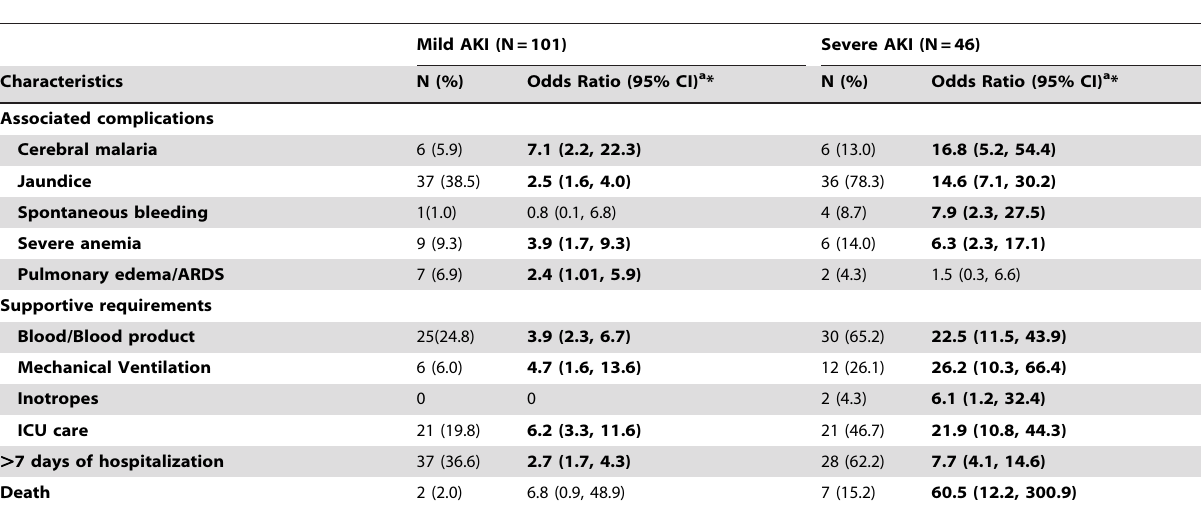
Table 9. Associations of AKI with complications and supportive requirements.